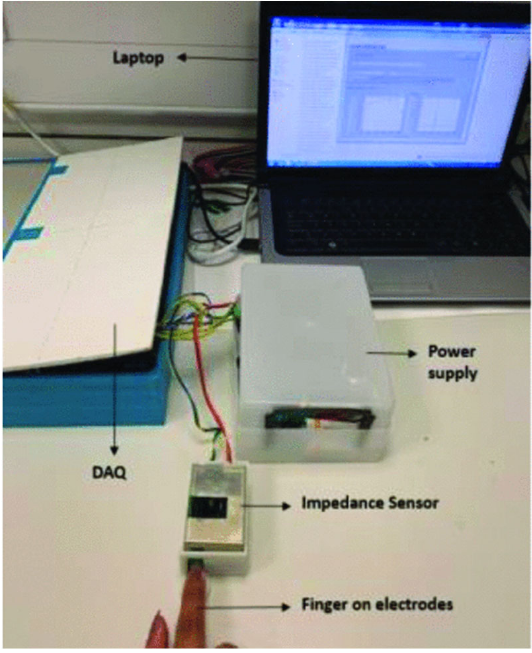
Figure 8. Laboratory setup for the sensing system [49].